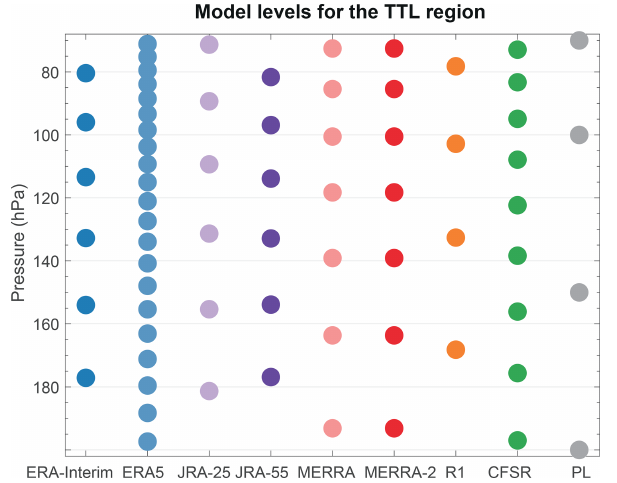
Figure 1. Model-level pressure values for different reanalysis data sets in the TTL using a fixed surface pressure of 1013.25hPa. Stan- dard pressure levels (PL) in the TTL region are also shown.